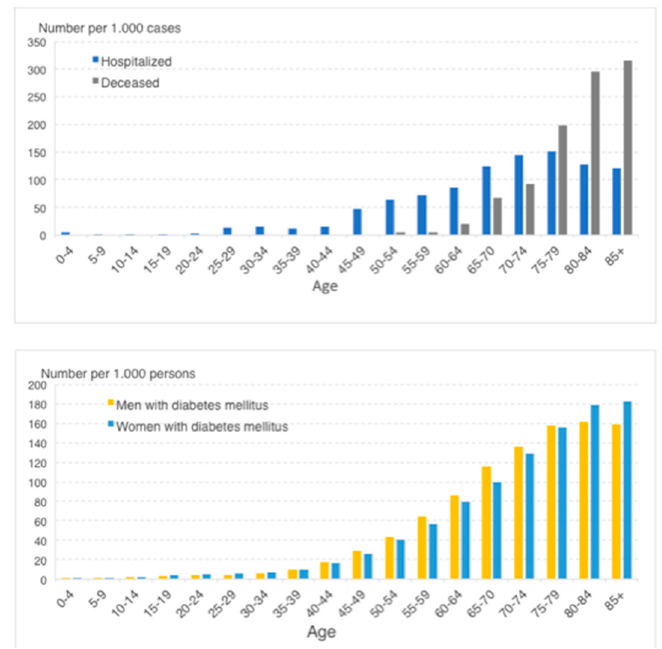
Figure 2. Upper panel: number of patients with DM (hospitalized and deceased) in patients with COVID-19 for different age groups; Lower panel: number of patients with DM in the general Dutch population for different age groups.